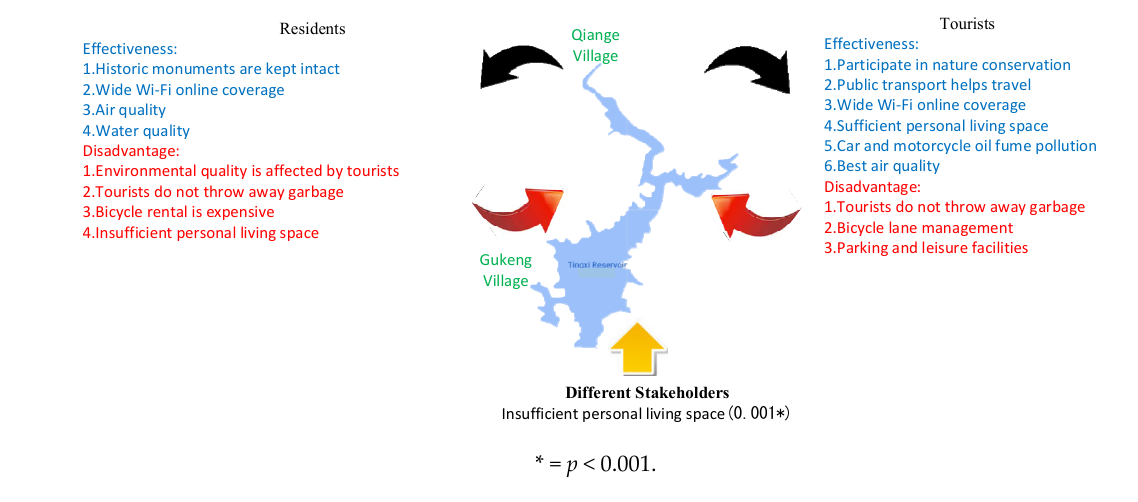
Figure 5. Perception analysis of current environmental developments.